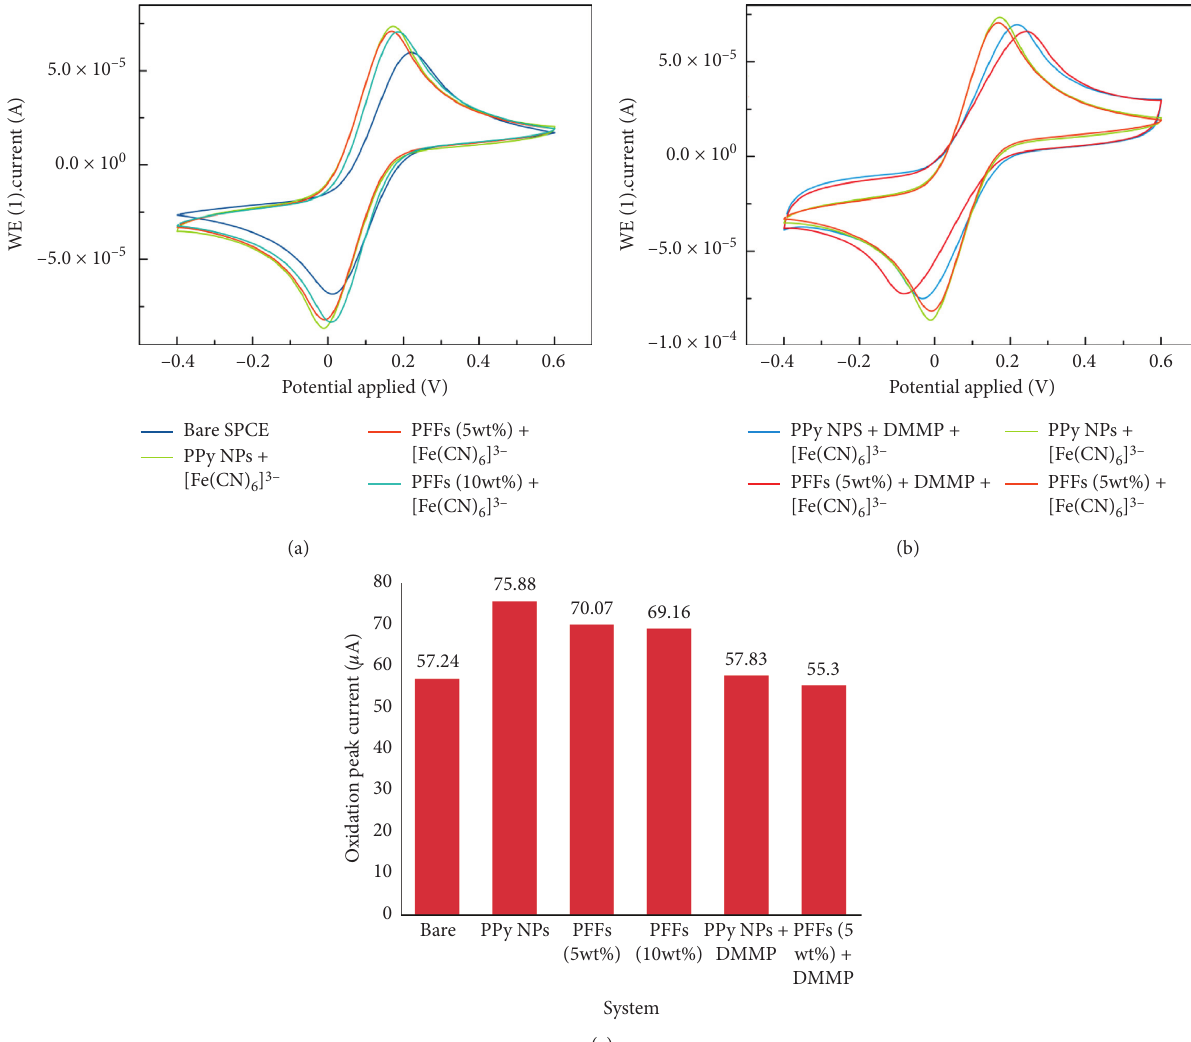
Figure 9: Cyclic voltammogram of bare electrode, PPy NPs, and 5 wt% and 10 wt% of PFFs without DMMP (a), PPy NPs and PFFs 5 wt% with DMMP (b), and oxidation peak current with different sensing materials on the surface of SPCE; PPy NPs, PFFs (5 wt%), PFFs (10 wt%), PPy NPs+DMMP, and PFFs (5 wt%)+DMMP